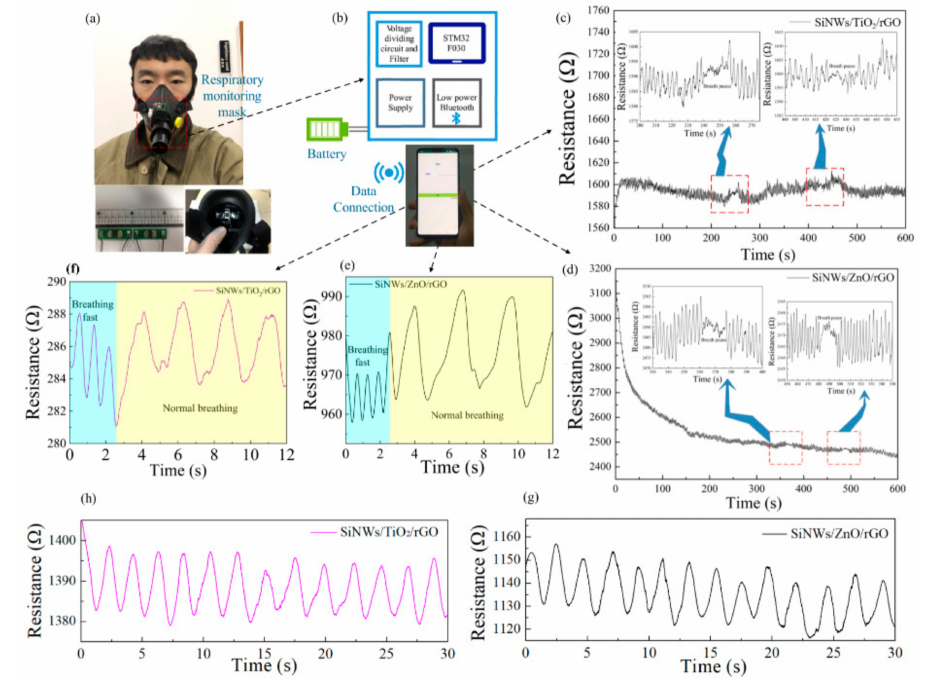
Figure 4. ( a , b ) Respiratory monitoring mask system. ( c , d ) 10-minute breath monitoring with the two types of sensors. ( e , f ) The resistance variation response to normal and fast breathing. ( g , h ) Response of both sensors measured after 30